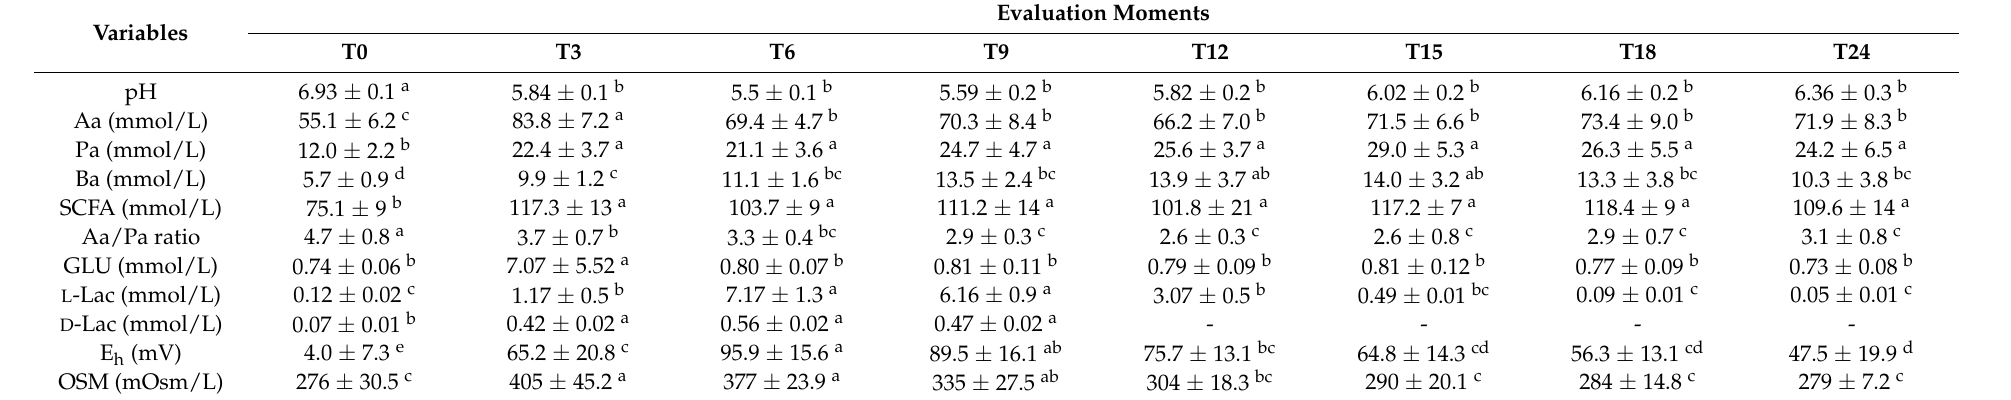
Table 1. Ruminal variables of cattle subjected to subacute ruminal acidosis (SARA) induction with the use of citrus